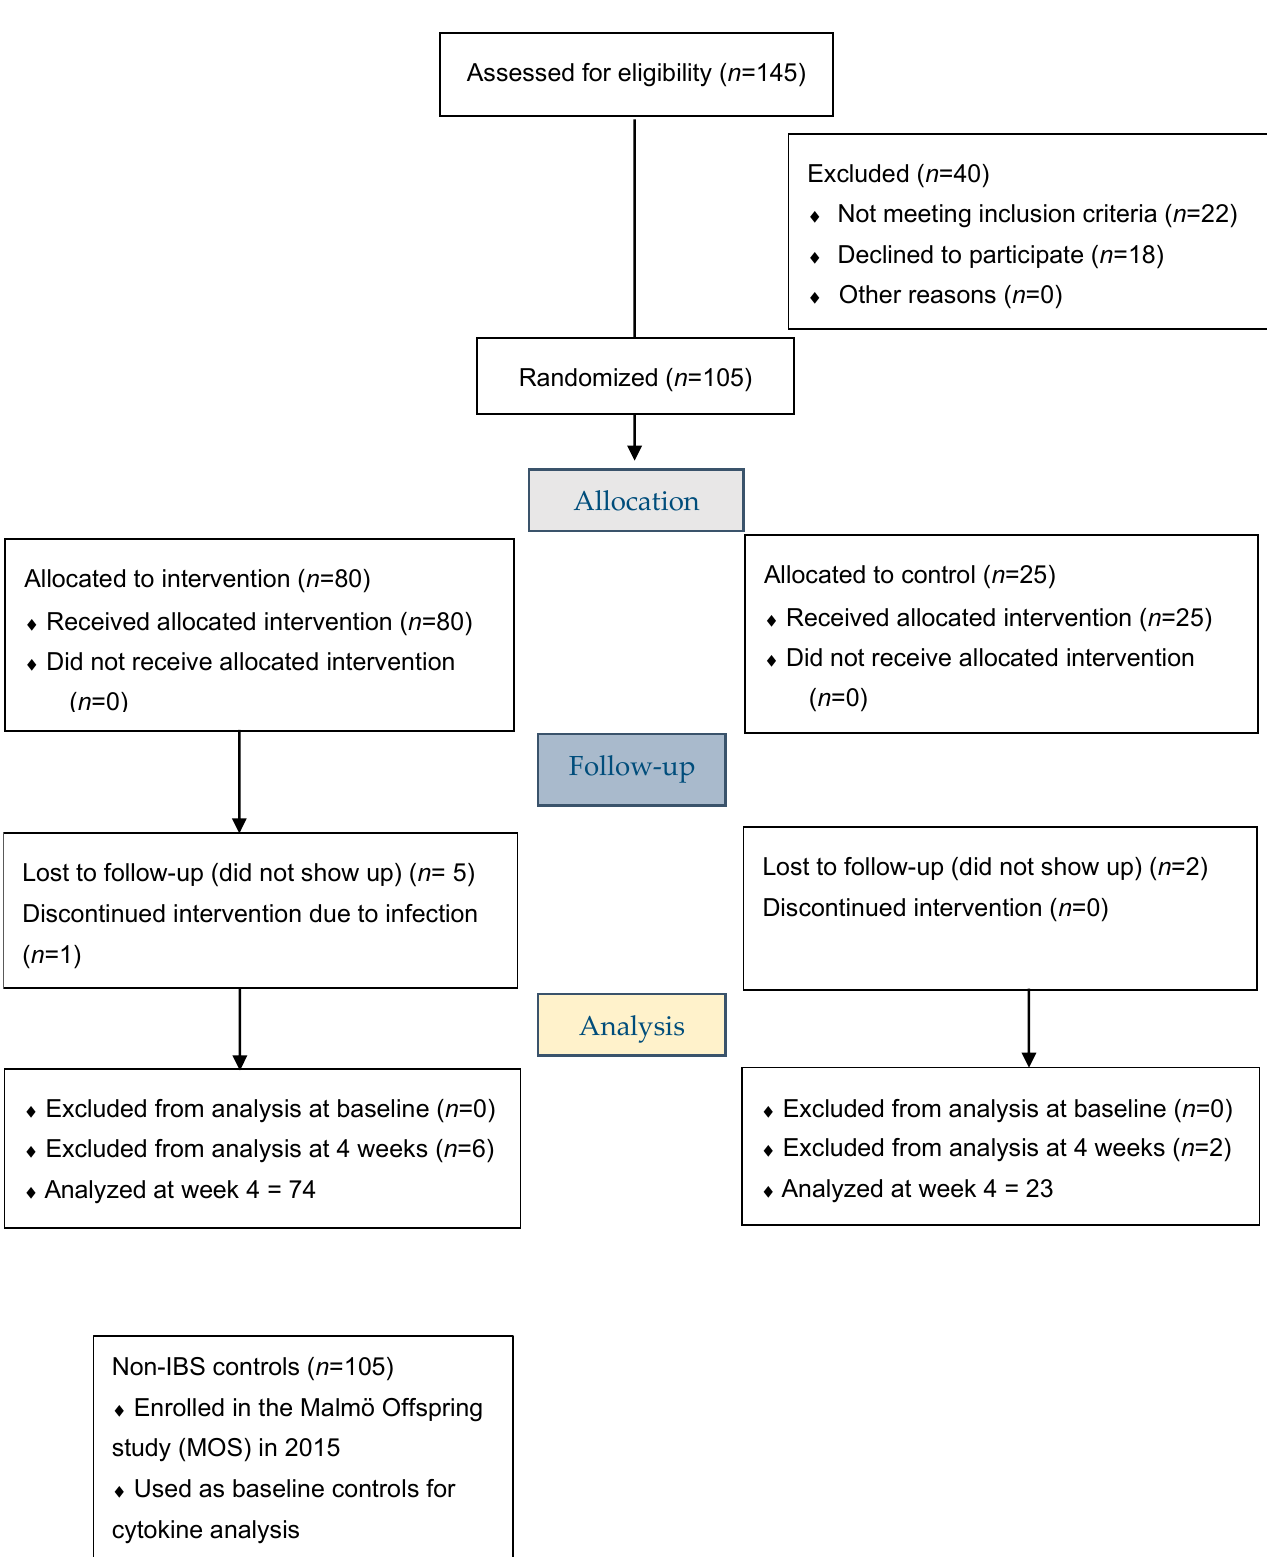
Figure 1. CONSORT 2010 Flow Diagram.